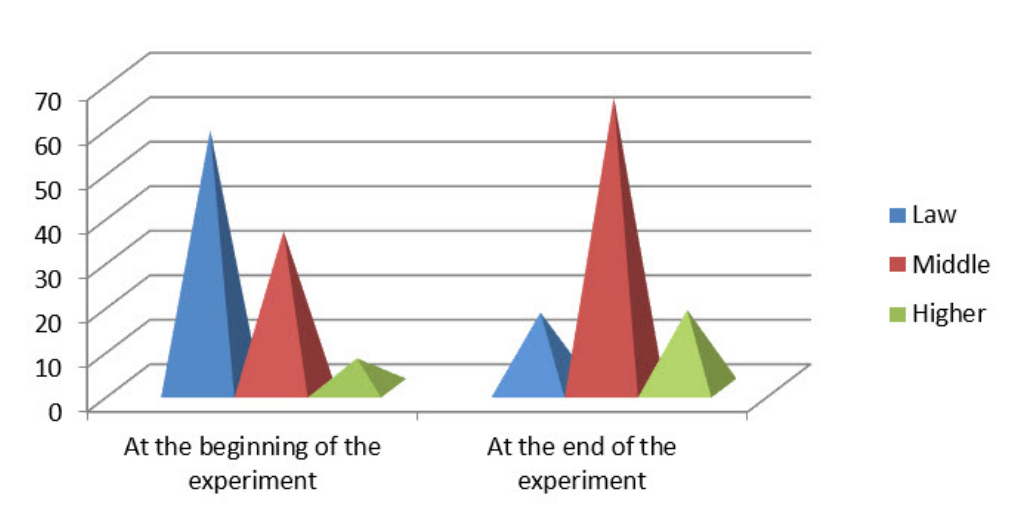
Figure 2. Chart of Experimental Group’s Percentage Indicators at the Beginning and end of